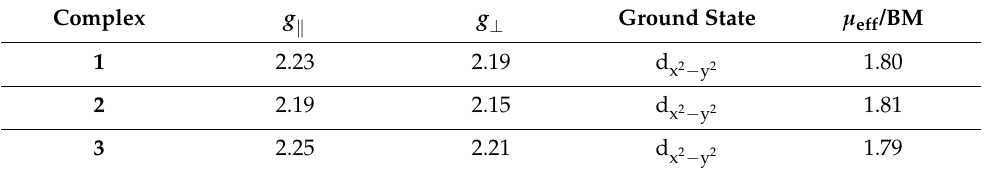
Table 3. EPR data and magnetic moments of copper(II) complexes.